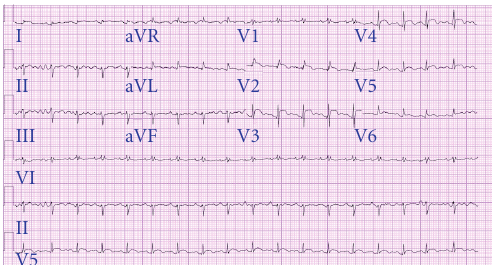
Figure 1: Electrocardiogram showing ST segment elevation in leads I, aVL, and V2–V6.